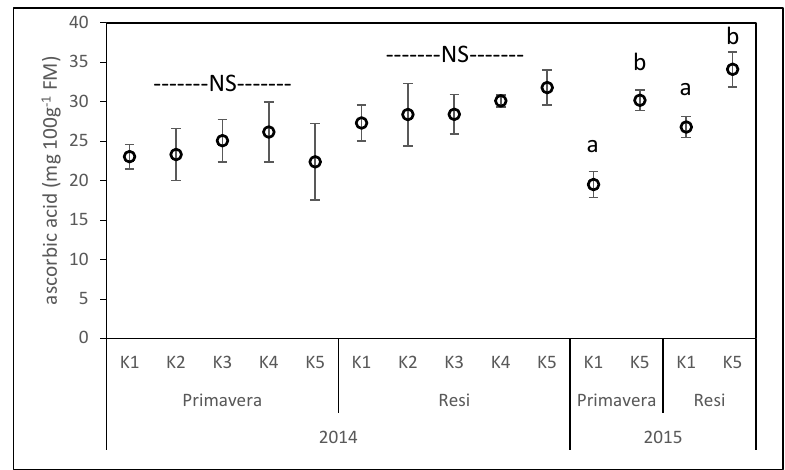
Fig. 2: K fertilization differently affects the ascorbic acid concentration of the cocktail tomato cultivars. K levels increase from K1 to K5 (0.37 g, 0.73 g, 1.47 g, 2.2 g, and 3.66 g K 2 SO 4 per week) for each cultivar. The mean values and standard deviations were determined from four biological replicates. Letters indicate statistically significant differences and NS indicates no significant difference, according to a Mann-Whitney-U or Tukey-HSD test.